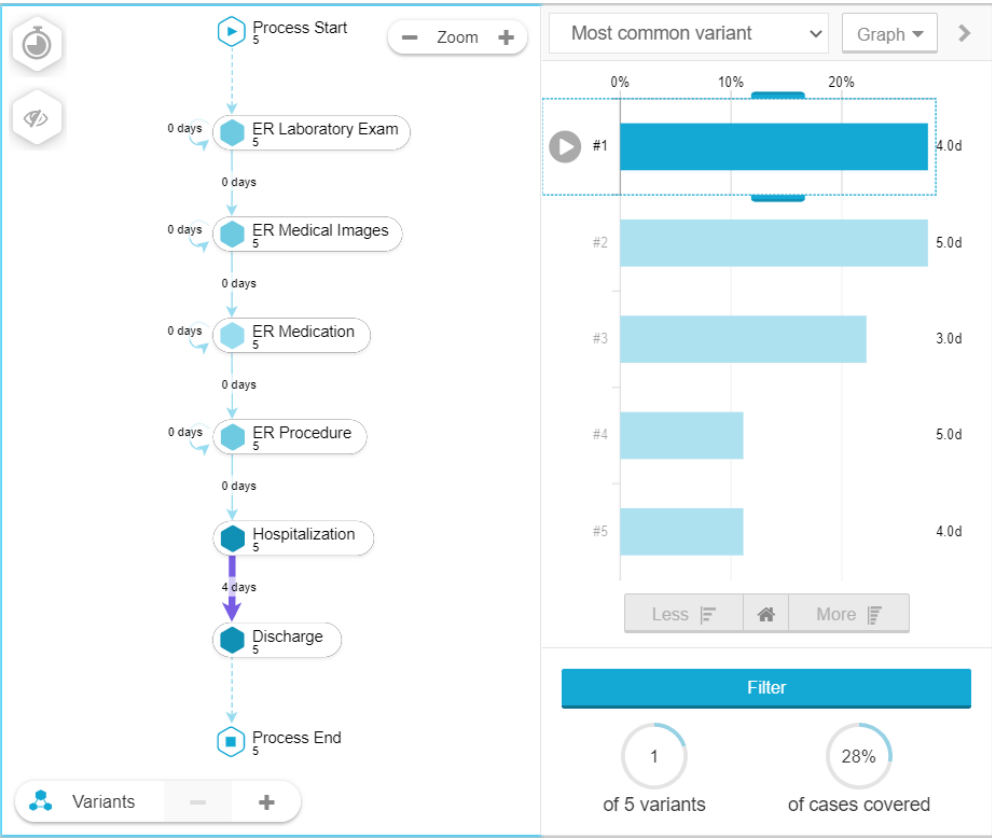
Figure 5. Variant analysis for pneumonia patients.